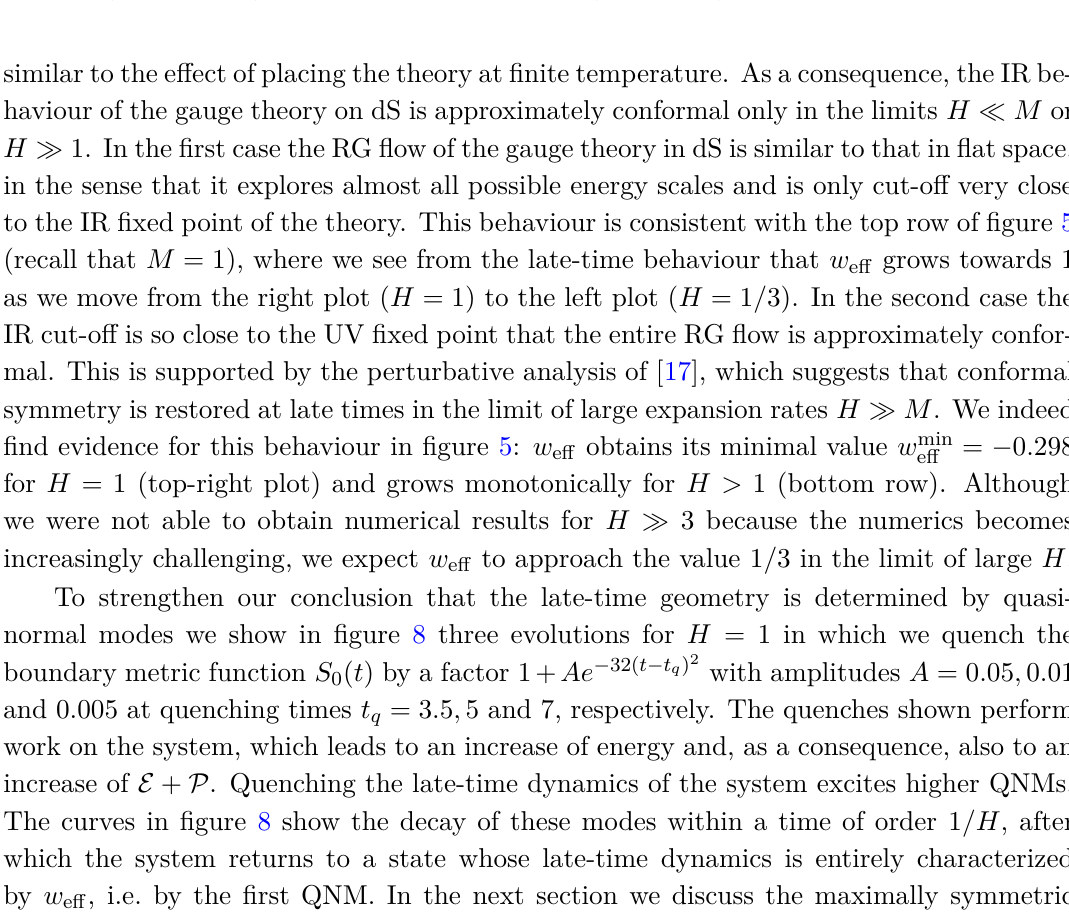
Figure 7 . Decay of E + P (solid blue) for H = 1 / 2 (left) and H = 2 (right), together with the QNM fit (dashed black) and their absolute difference (dashed